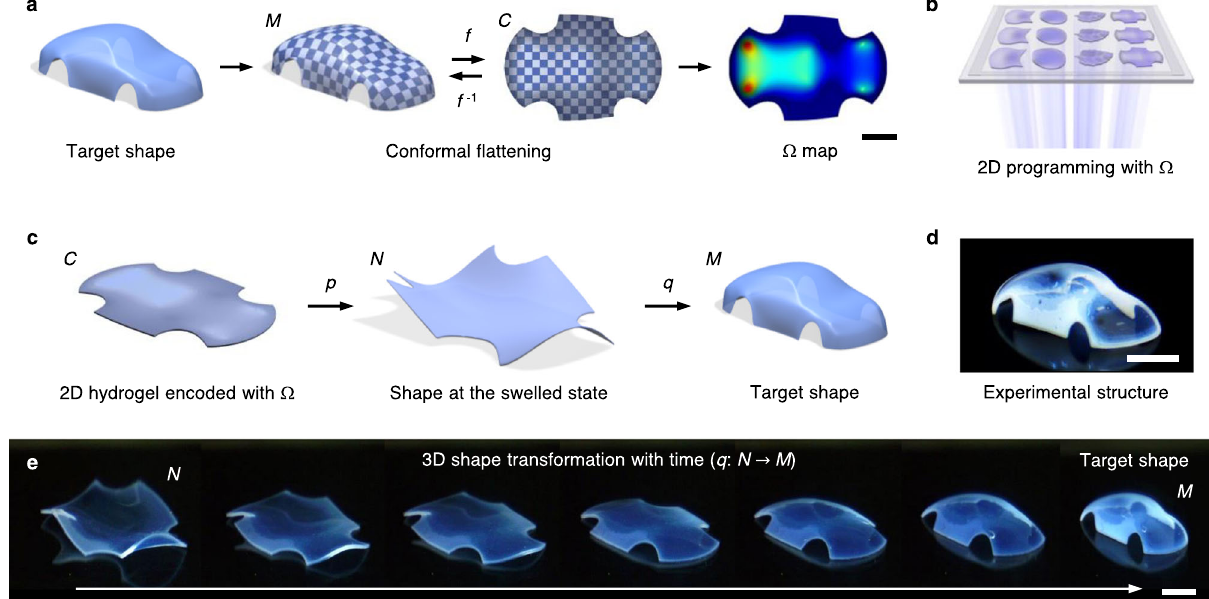
Fig. 1 2D material programming for 3D shaping. a Translation of a 3D target shape M into 2D growth Ω via conformal mapping f of M to the plane C ( f : M → C ). The value of Ω ranges from 0.36 (blue) to 0.76 (red). b 2D printing of hydrogel sheets encoded with Ω from a single precursor solution using digital light projection grayscale lithography. c Schematic illustrating a shape transformation process of a 2D hydrogel C encoded with Ω in a to the target 3D shape M at the shrunk state ( f − 1 : C → M ). The 2D hydrogel C transforms to the prescribed 3D shape N at the swelled state ( p : C → N ) upon immersion in water ( T < T c ), where T c is the volume phase transition temperature of the hydrogel (~32.5 °C). The 3D structure N at the swelled state reversibly transforms to the target 3D shape M at the shrunk state ( q : N → M ) upon temperature increase ( T > T c ). d Experimental 3D structure obtained through the process shown in a – c . e Experimental 3D shape transformation of N to M with time. Scale bars, 5 mm in a ; 4 mm in d and e